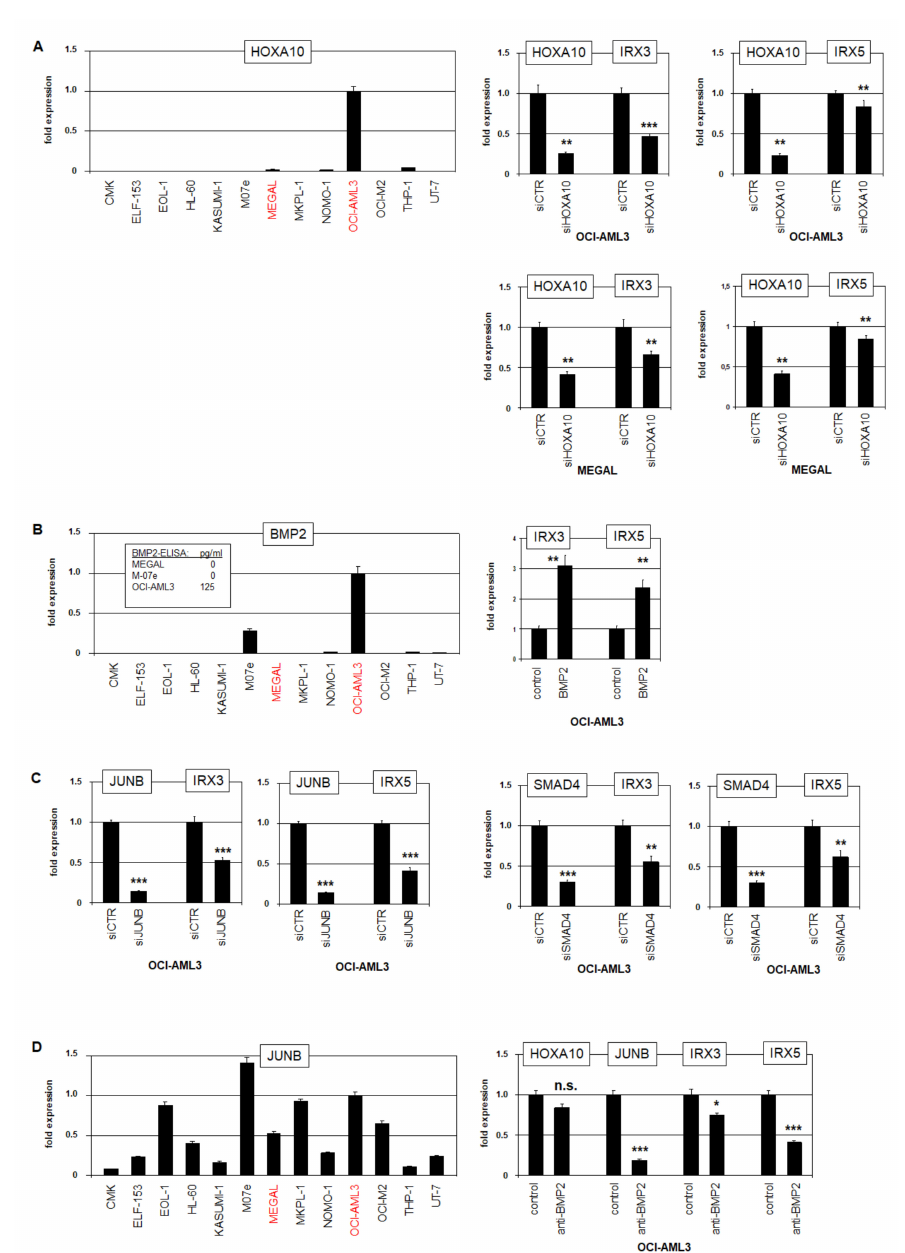
Figure 5. Transcriptional regulation of IRX3 and IRX5. ( A ) RQ-PCR analysis of HOXA10 in AML cell lines ( left ). Transcript levels are indicated in relation to OCI-AML3, and IRX3/IRX5-positive cell lines are indicated in red. RQ-PCR analysis of OCI-AML3 ( above ) and MEGAL ( below ) showed downregulation of IRX3 and IRX5 after siRNA-mediated knockdown of HOXA10 ( right ). ( B ) RQ-PCR analysis of BMP2 in AML cell lines ( left ). Transcript levels are indicated in relation to OCI-AML3. ELISA results for BMP2 protein levels in AML cell line supernatants are inserted. RQ-PCR analysis of OCI-AML3 treated with BMP2 resulted in the upregulation of IRX3 and IRX5 ( right ). ( C ) RQ- PCR analysis of OCI-AML3 after siRNA-mediated knockdown of JUNB ( left ) and SMAD4 ( right ) showed downregulation of IRX3 and IRX5. ( D ) RQ-PCR analysis of JUNB in AML cell lines ( left ). Transcript levels are indicated in relation to OCI-AML3. RQ-PCR analysis of OCI-AML3 treated with inhibitory BMP2-antibody resulted in downregulation of JUNB, IRX3, and IRX5, while HOXA10 was not significantly affected ( right ). p -values are indicated by asterisks (* p < 0.05, ** p < 0.01, *** p < 0.001, n.s. not